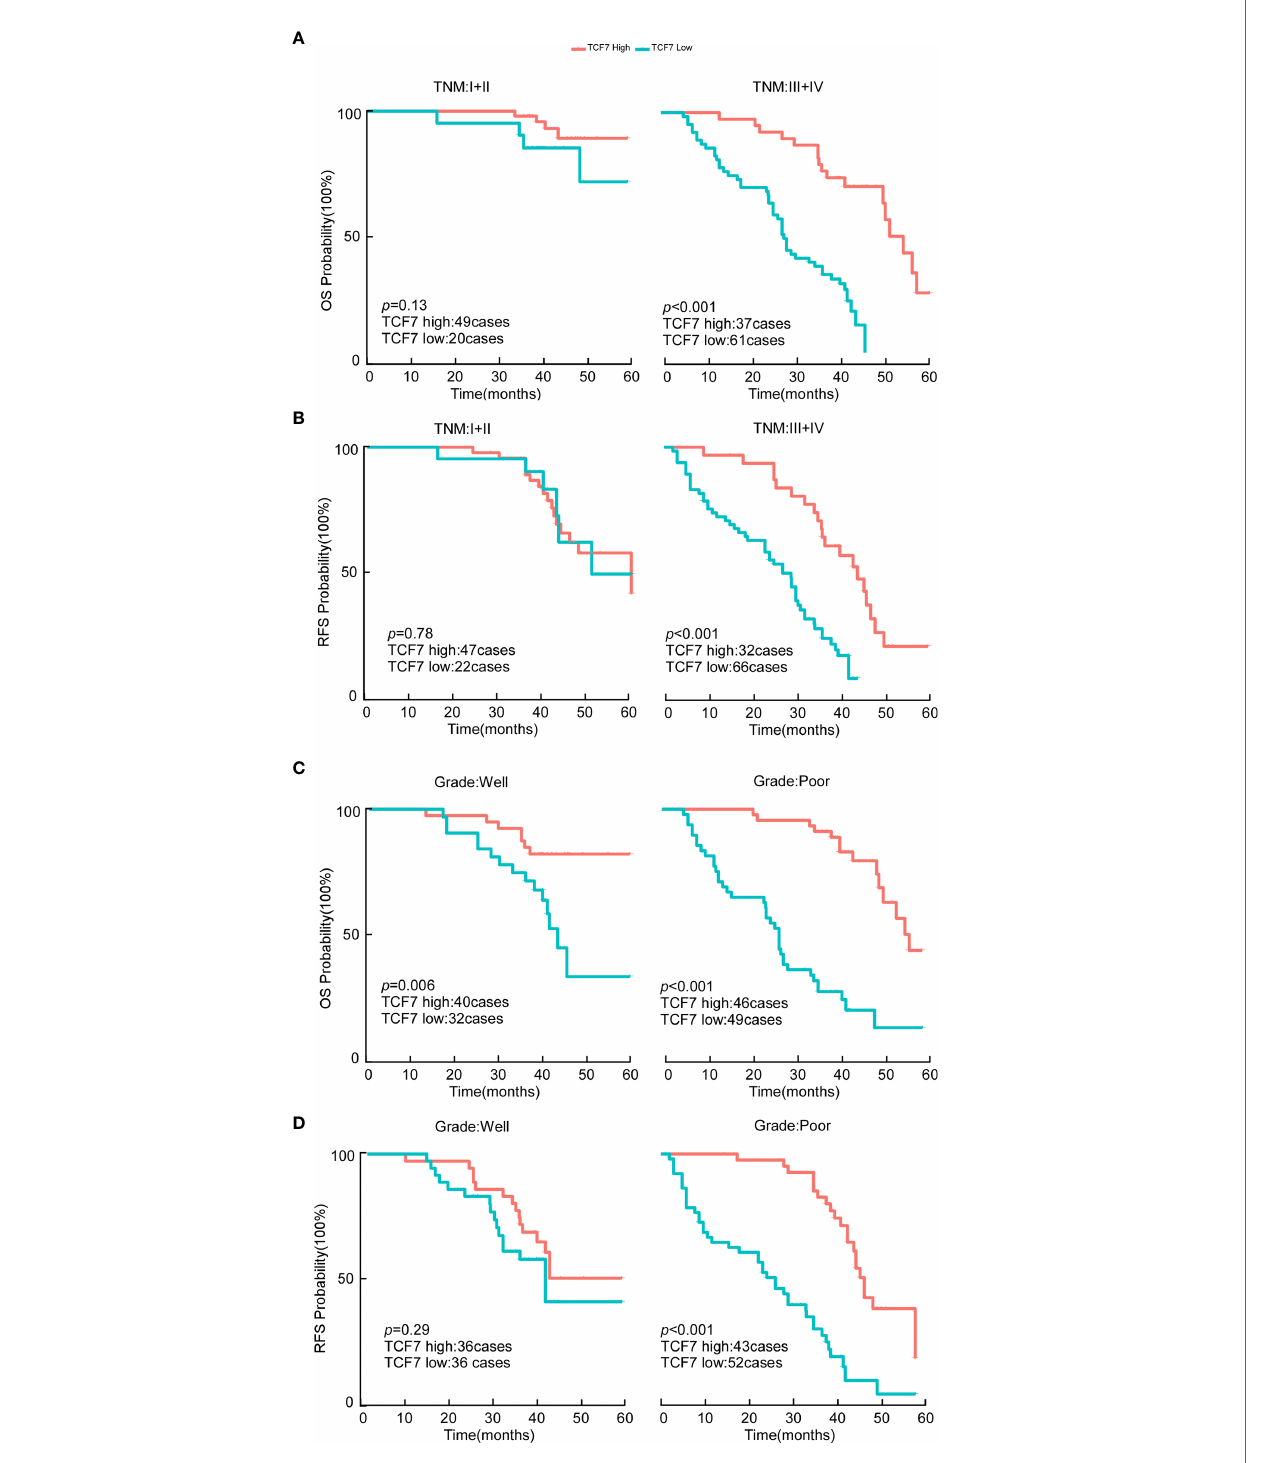
FIGURE 2 | OS and RFS analysis of OSCC patients in the TCF7 + T cell high expression group versus the TCF7 + T cell low expression group. (A) Kaplan – Meier analysis of OS in the TNM low-risk group (n=69) and high-risk group (n=98). (B) Kaplan – Meier analysis of RFS in the TNM low-risk group (n=69) and high-risk group (n=98). (C) Kaplan – Meier analysis of OS in the histological grade low-risk group (n=72) and high-risk group (n=95). (D) Kaplan – Meier analysis of RFS in the histological grade low-risk group (n=72) and high-risk group (n=95). The p values of survival curves were calculated by the log-rank test. p <0.05 was considered to indicate signi fi cance. OS, overall survival; RFS, recurrence-free